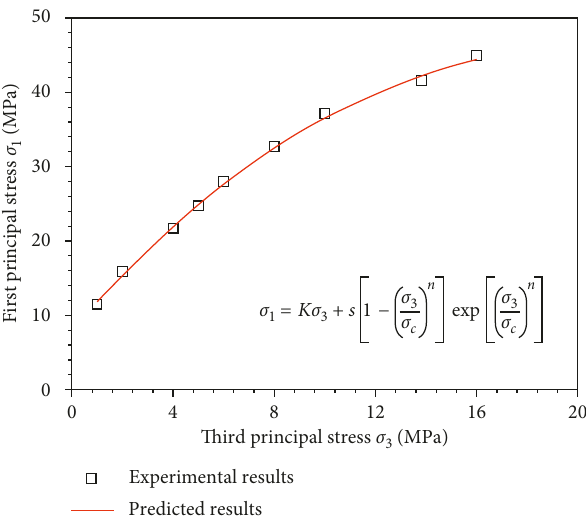
Figure 3: The relationship between the first principal stress and the third principal stress of frozen sandy